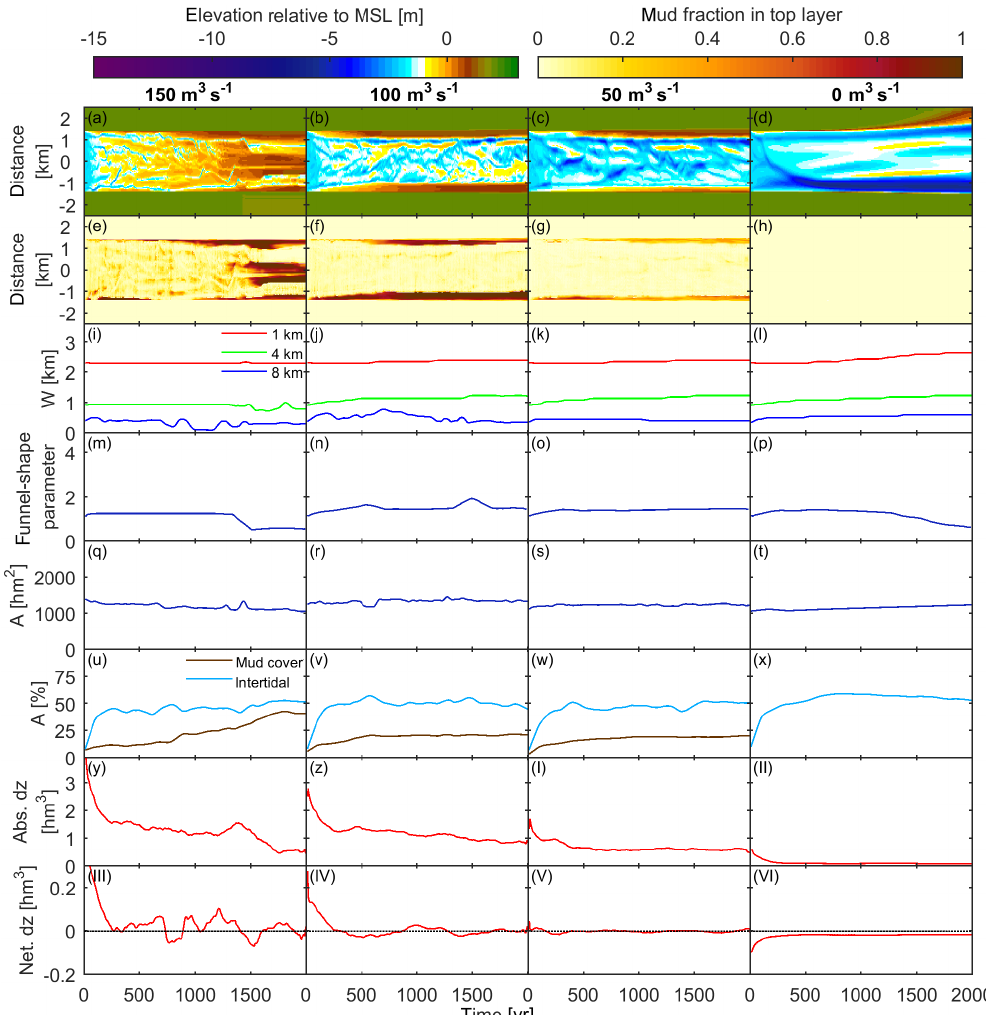
Figure A6. Hydrodynamics and morphodynamics over time for estuaries with different discharge. From left to right (columns): model with river discharge of 150 (08), 100 (default, 01), 50 (07) and 0m 3 s − 1 (22). (a–d) Bathymetry of the cross section at the mouth plotted over time, (e–h) mud fraction in the top layer of the cross section at the mouth, (i–l) estuary width at 1, 4 and 8km from the mouth, (m–p) funnel-shape parameter, (q–t) estuarine surface area, (u–x) intertidal area and mud in the bed relative to the total area, (y–II) absolute bed level change and (III–VI) net bed level